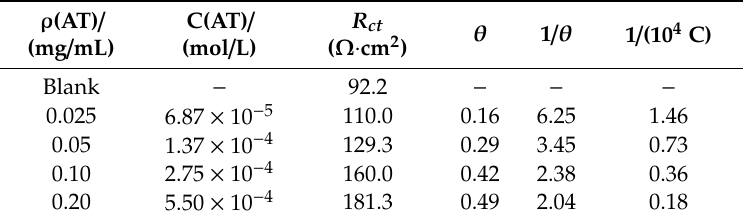
Table 4. Adsorption parameter of AT on Q235 steel electrodes.